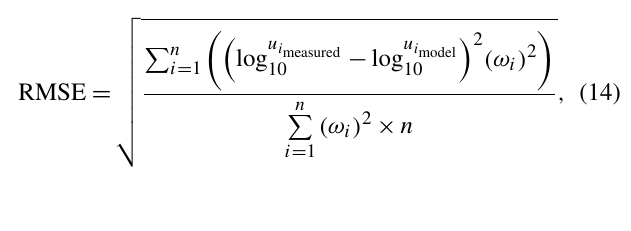
Figure 1. Influence of various parameters upon γ HO (b) γ HO denoted by black squares and black line and k het in red circles and red line increase with aerosol particle condensed-phase 2